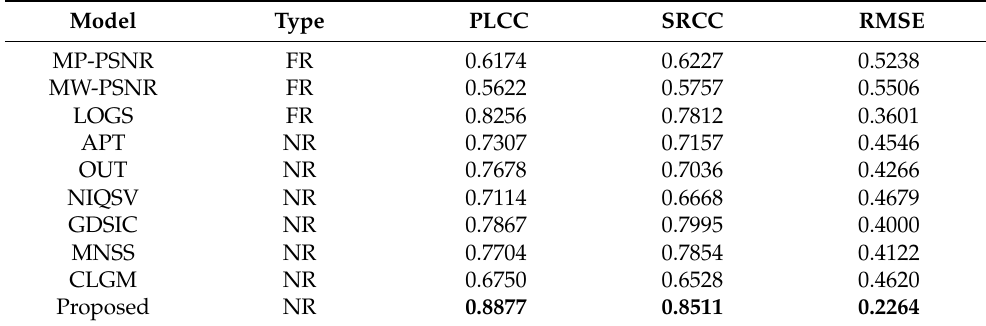
Table 2. Performance comparison of our designed algorithm with the current mainstream DIBR IQA models on the IRCCyN/IVC database.